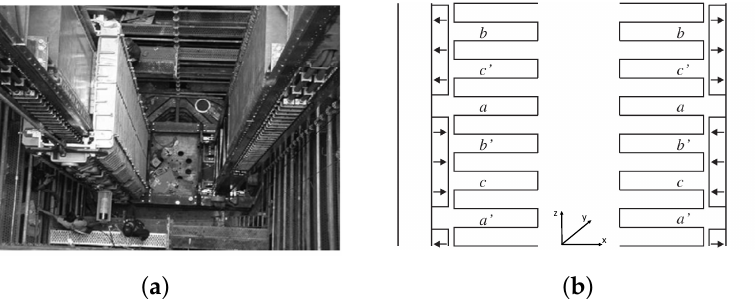
Figure 2. The photo of the reference linear electrical machine in the pilot of the AWS WEC, and the cross-section of the linear PM generator of the AWS plant. In figure ( b ), a/a’, b/b’ and c/c’ are the current directions [39], and the "z" axis in the coordinate is perpendicular to the ground plane. ( a ) Photo of the reference machine. ( b ) Cross-Section of the